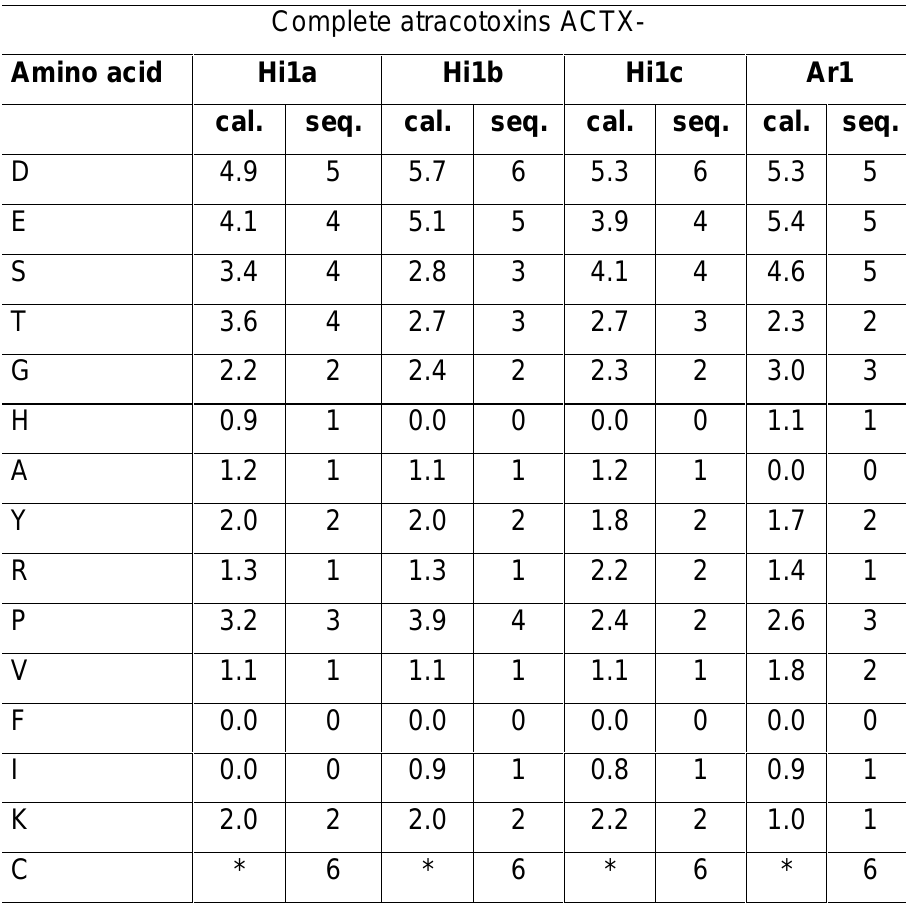
Table 2.1: Amino acid composition of the toxins. Complete atracotoxins